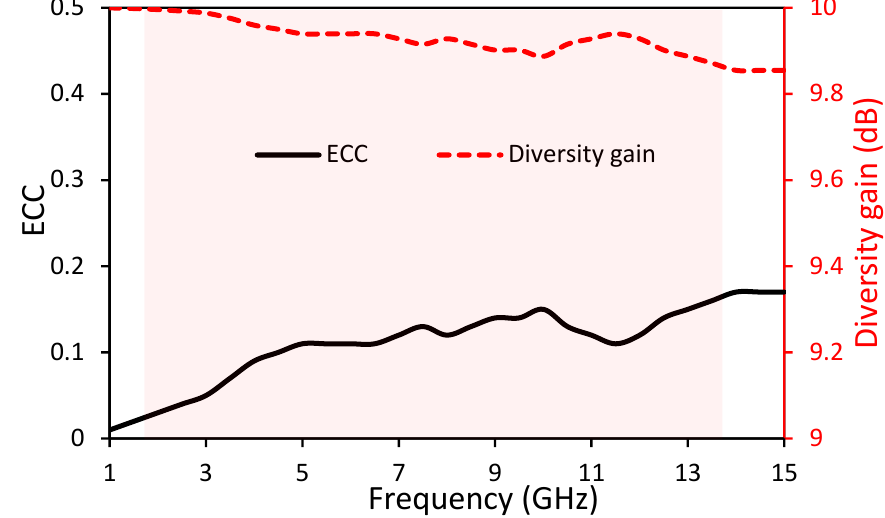
Figure 12. Envelope correlation coefficient (ECC) and Diversity Gain (DG) of the UWB-MIMO antenna